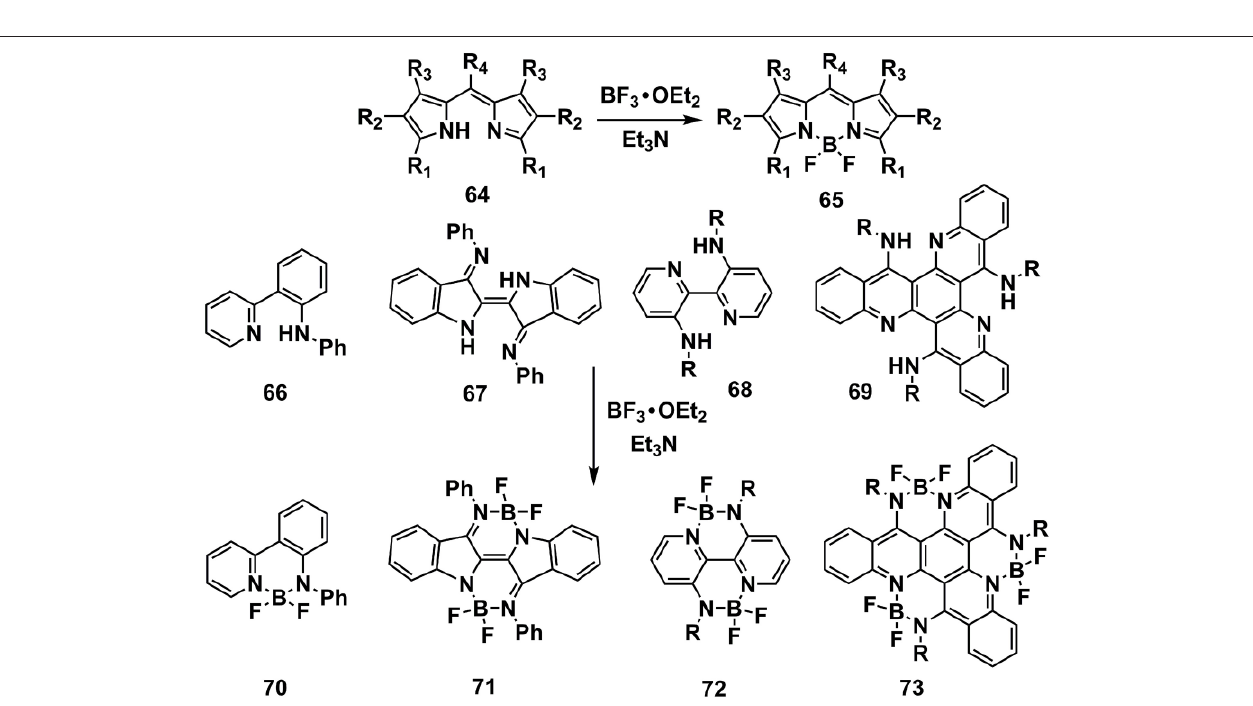
FIGURE 6 | Examples of synthesis routes toward B-N embedded units via chelation of aromatic N and B precursor.